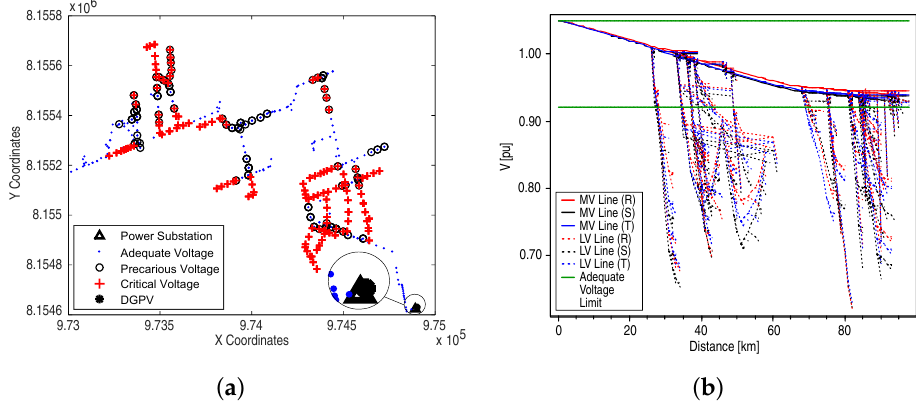
Figure 20. Analysis 2: ( a ) voltage rating and ( b ) voltage